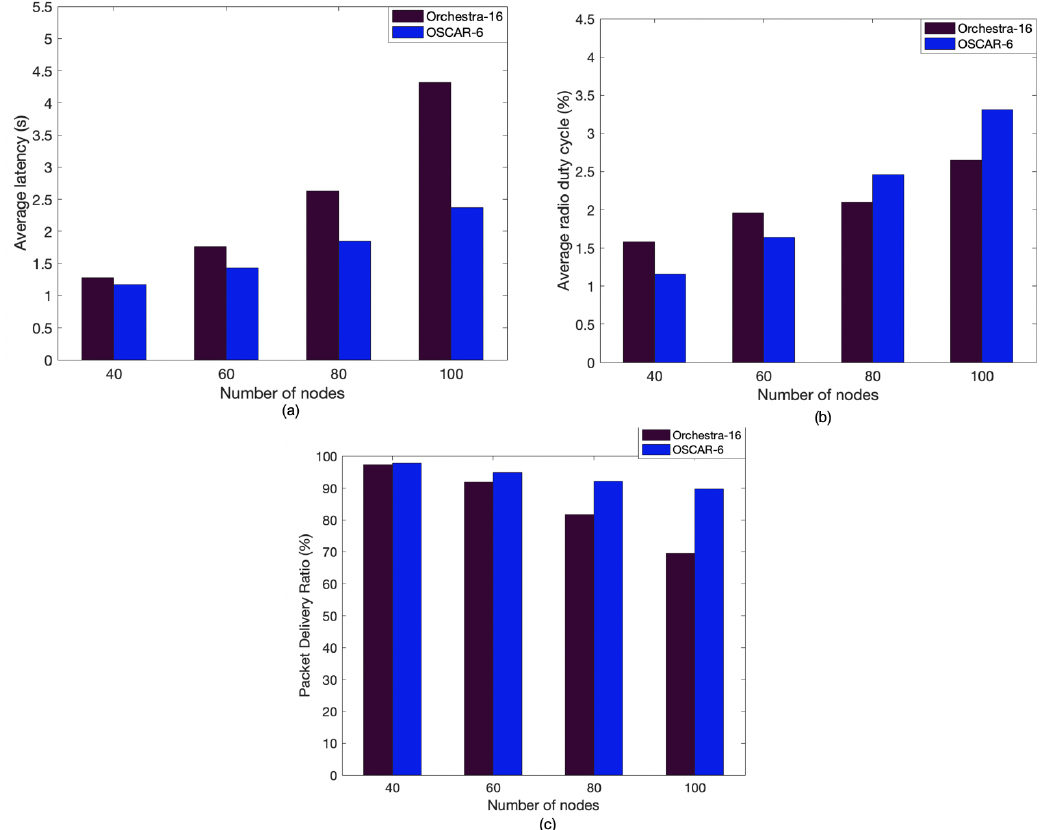
Figure 9. Comparison between Orchestra and OSCAR according to the number of nodes in the simulation: ( a ) average end-to-end delay, ( b ) average radio duty cycle, and ( c ) average packet delivery